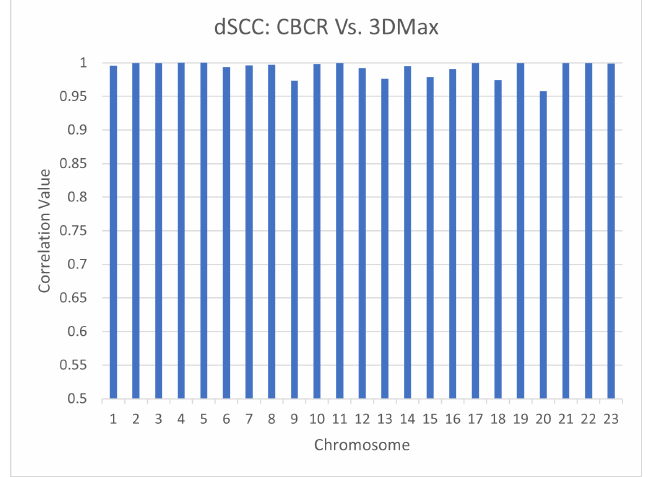
Figure 18. dSCC calculated between the outputs of CBCR and the outputs of 3DMax on GM12878 at 100 kb